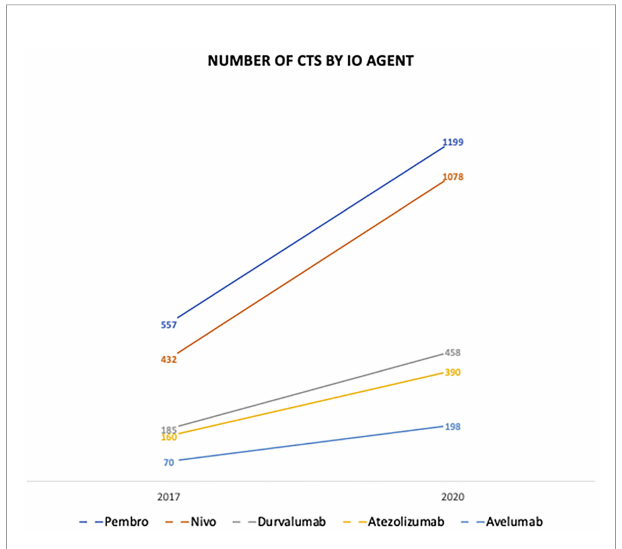
FIGURE 1 | The number of clinical trials in IO by ICI agent from 2017-2020. IO, Immuno-Oncologic Therapy; ICI, Immune-Checkpoint